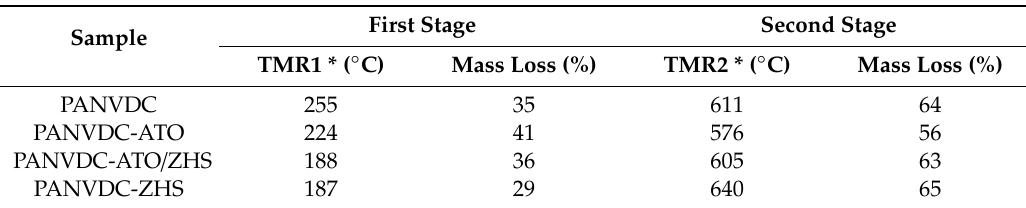
* TMR1 and TMR2: Temperature at the maximum rate of mass loss (%/°C) in the first and second stages, respectively.